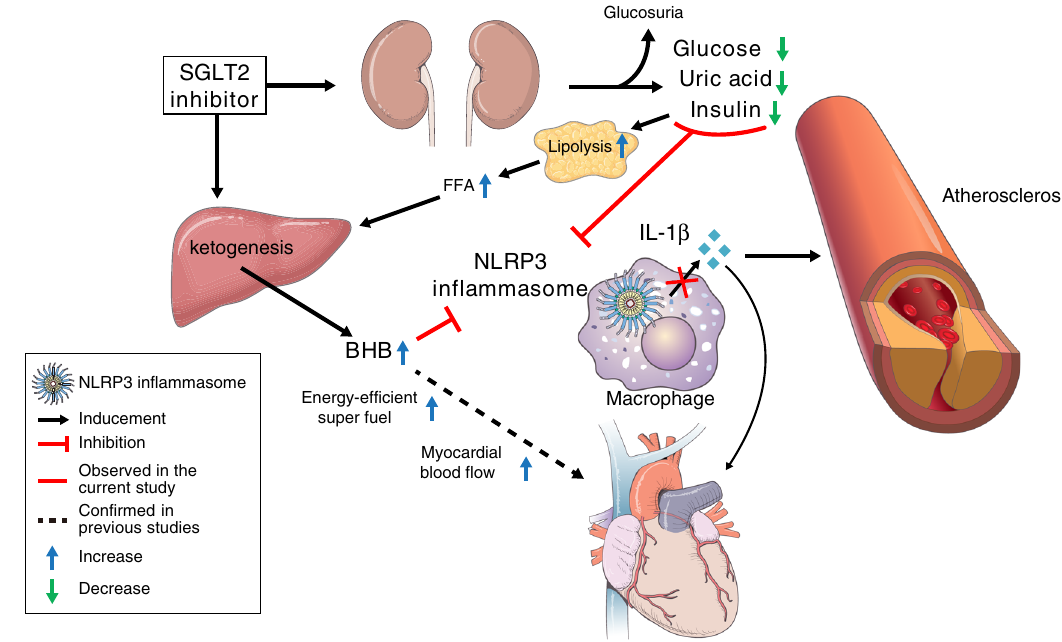
Fig. 5 Scheme representing the proposed effects of SGLT2 inhibitor on NLRP3 in fl ammasome activation. BHB β -hydroxybutyrate, FFA free fatty acid, IL- 1 β interleukin-1 β , NLRP3 NLR family, pyrin domain-containing 3, SGLT2 sodium – glucose cotransporter